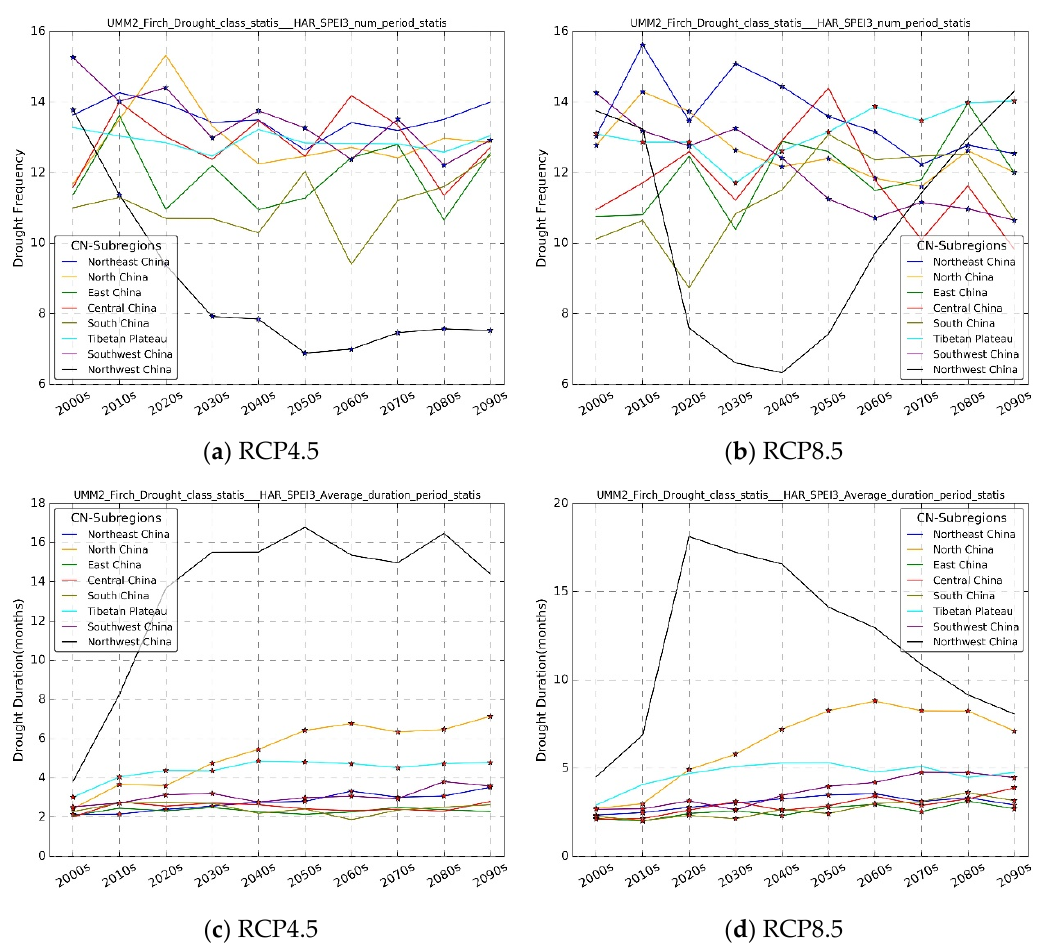
Figure 7. Temporal variation of regional drought frequency (top row: ( a , b )) and drought duration (bottom row: ( c , d )) on the decadal scale over eight climate regions. The red-filled star symbol represents positive trends, while the blue-filled star symbol represents negative trends.